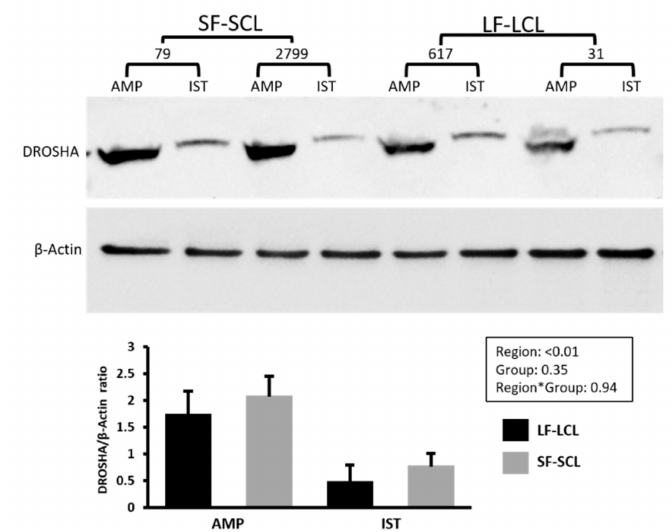
Figure 2. Protein levels of DROSHA from oviductal cells obtained from animals treated to ovulate a large or a small follicle. Quantification of Drosha ribonuclease III (DROSHA) protein expression ( n = 4 per group) in the ampulla (AMP) and isthmus (IST) ipsilateral to the CL from beef cows synchronized to ovulate a large (LF-LCL) or a small follicle (SF-SCL) on day 4 of the estrous cycle. Bar graph shows the ratio of optical density of the bands corresponding to DROSHA and β